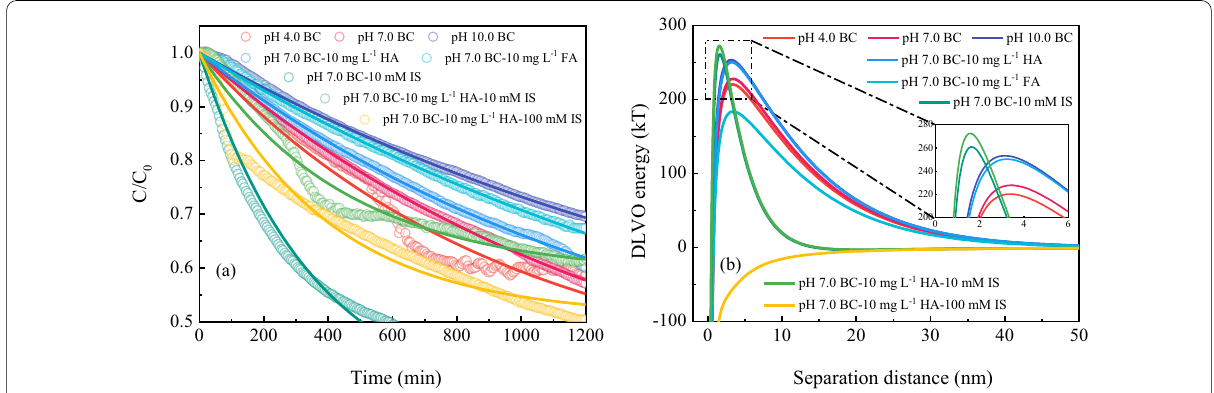
Fig. 1 Settling kinetics ( a symbols indicate observed data points and lines indicate simulation fitting) and DLVO energies ( b ) of the BCNPs with varying conditions (pH, IS, and